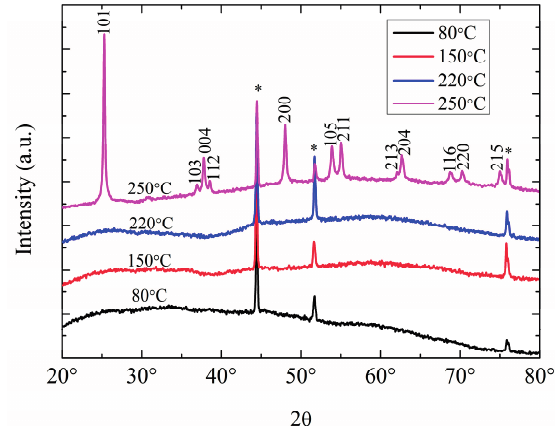
Figure 4. XRD patterns of pure TiO nanoparticles heat-treated at 80 °C, 150 °C, 220 °C, 2 and 250 °C was obtained by using CuK α radiation at λ = 1.5406 µm, (*) shows substrate Incubo